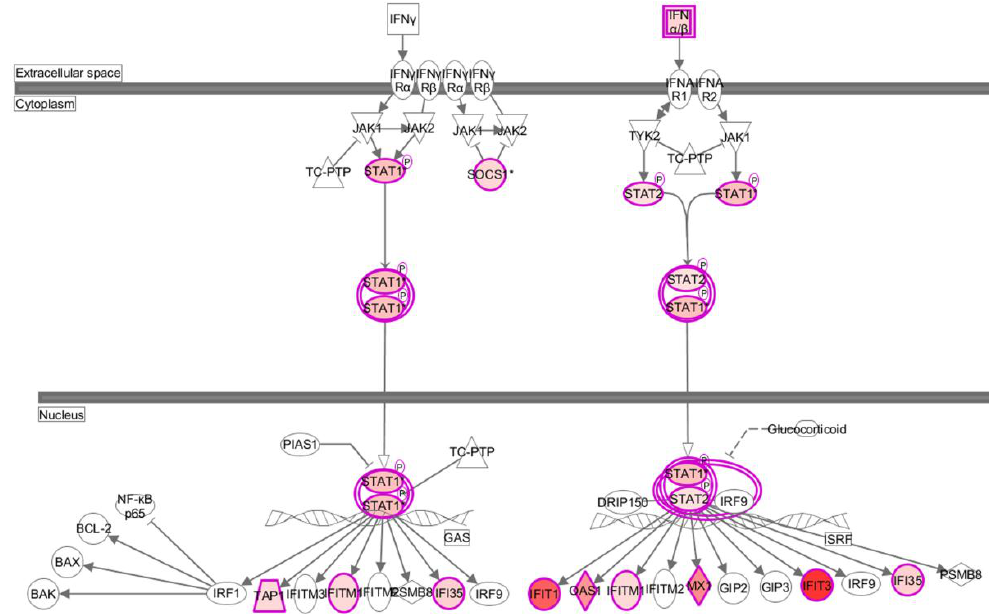
Figure 7. IFN pathway in response to virus infection at 24 hpi. DE genes were submitted to IPA, and IFN pathway in response to virus infection at 24 hpi was constructed. The size and color of nodes reflect the degree of expression difference between control and H5N1 infection. Nodes in red color indicate upregulated genes; Nodes in white color indicate insignificantly changed